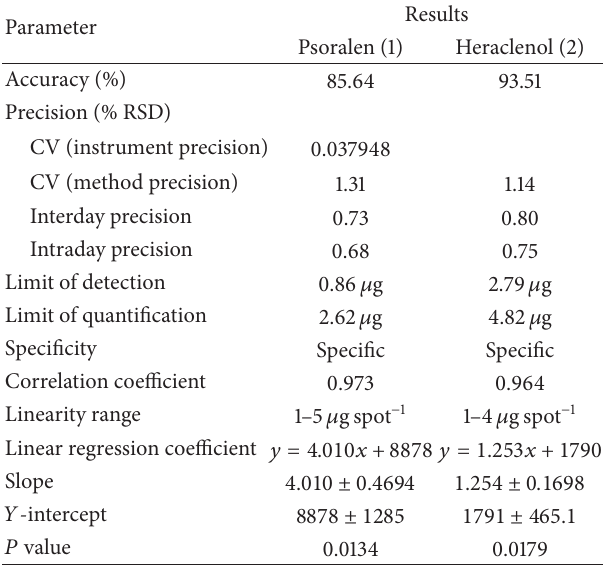
Table 1: Method validation parameters for the estimation of psoralen and heraclenol by HPTLC densitometry.